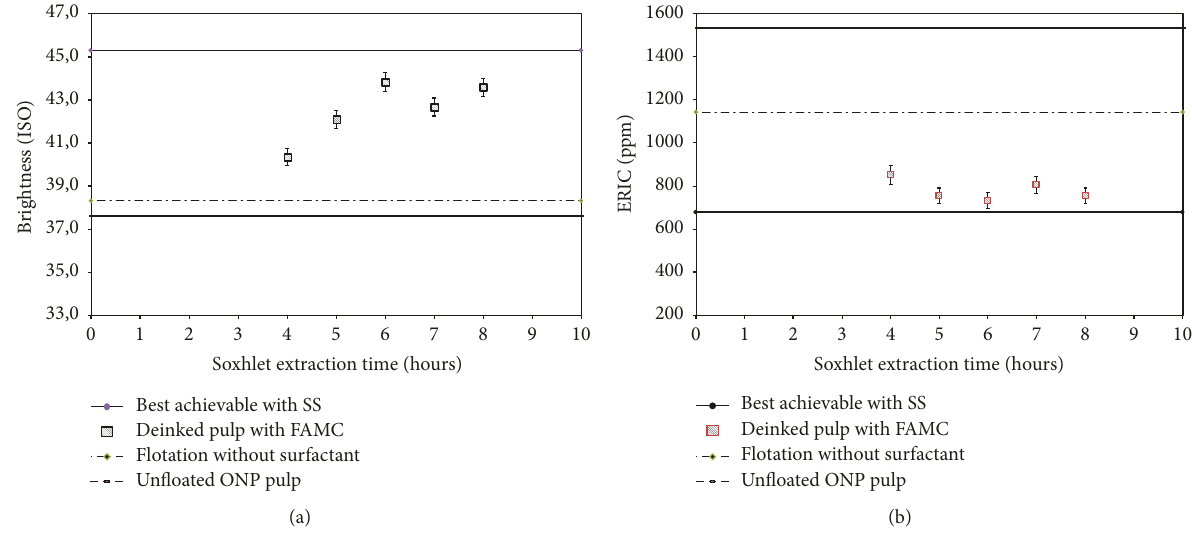
Figure 3: (a) Brightness achievement; (b) ERIC achievement of deinked pulp after deinking flotation with FAMC isolated at different Soxhlet extraction